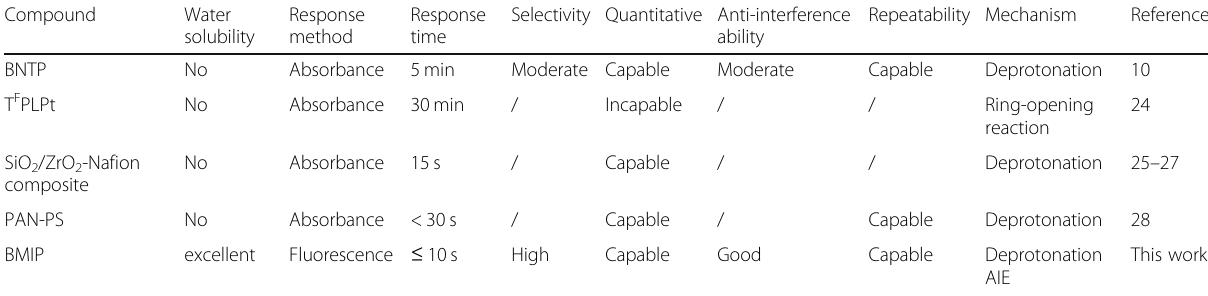
Table 1 The comparison between previous works and our work about the detection of extreme alkalinity (pH > 14) Compound Water Response Response Selectivity Quantitative Anti-interference Repeatability Mechanism solubility method time ability